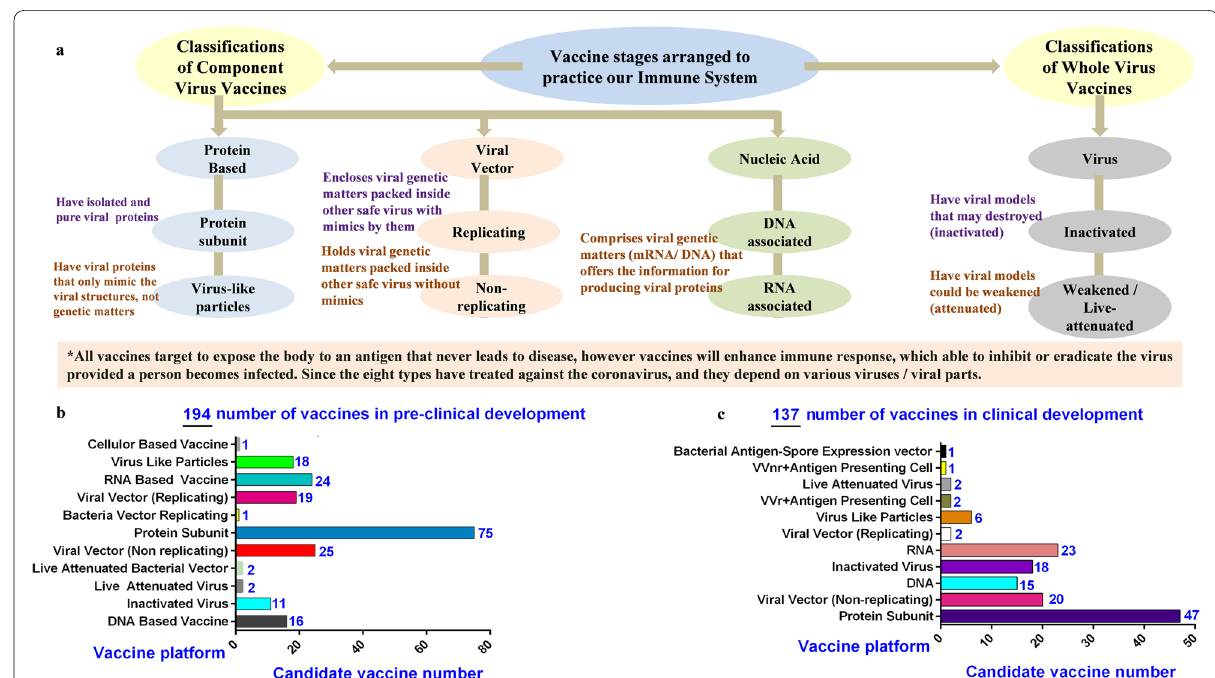
Fig. 8 Representative vaccines platforms are arranged to train our immune system as classified in to a Component Virus Vaccines with sub divisions of protein based as protein subunit and virus like particles; further viral vector as replicating and non-replicating; nucleic acid as RNA based and DNA based; b Whole Virus Vaccines with sub divisions of Virus as inactivated and weakened / live-attenuated; b Number of vaccines in pre-clinical stage (194); c Vaccines under clinical development